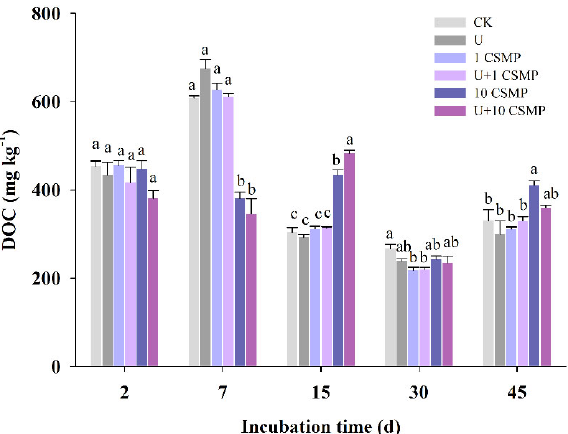
Figure 3. Soil dissolved organic carbon as affected by the amendment during the incubation. CK, no mineral amendments or urea; U, urea at 60 mg N kg − 1 soil; 1 CSMP, 1 g CSMP kg − 1 soil; U+1 CSMP, urea at 60 mg N kg − 1 + 1 g CSMP kg − 1 soil; 10 CSMP, 10 g CSMP kg − 1 soil; U+10 CSMP, 60 mg N kg − 1 + 10 g CSMP kg − 1 soil. Error bars represent standard error of the mean (n = 3). Different lowercases indicate significant differences among treatments ( p <